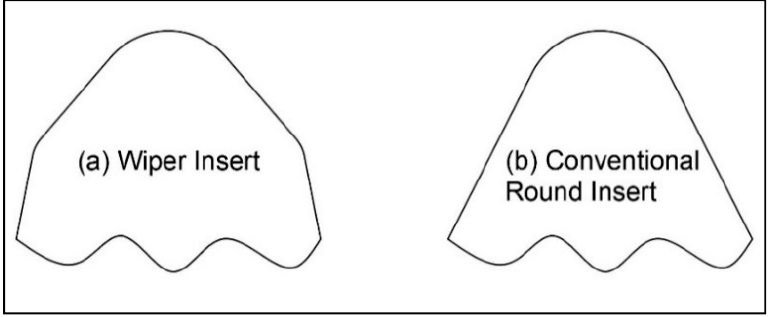
Figure 1. Schematic drawing of the used carbide inserts: ( a ) wiper insert; ( b ) conventional insert.